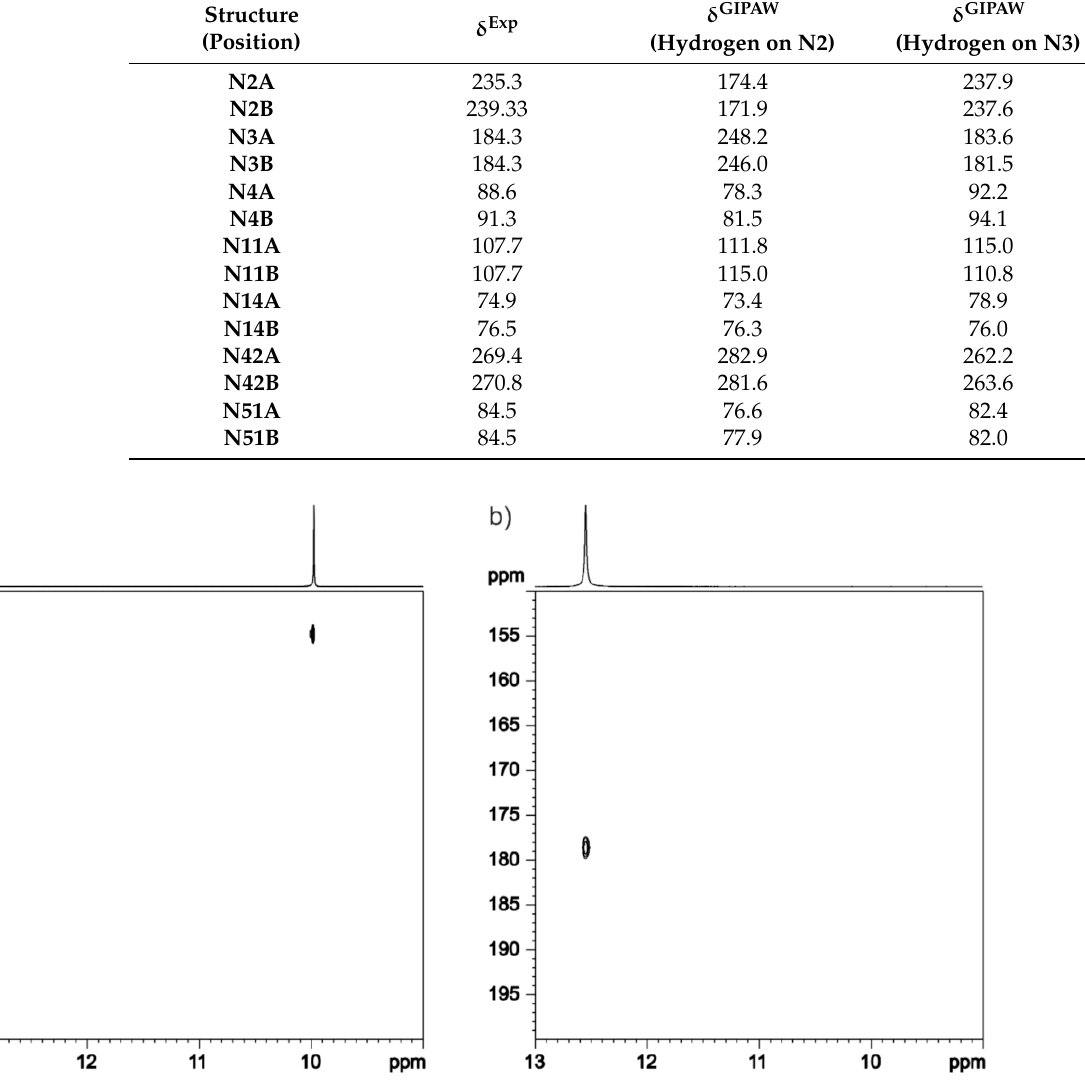
Figure 15. 15 N CP NMR solution spectra in DMSO-d 6 of compound 1 ( a ) and compound 4 ( b ), recorded at 298